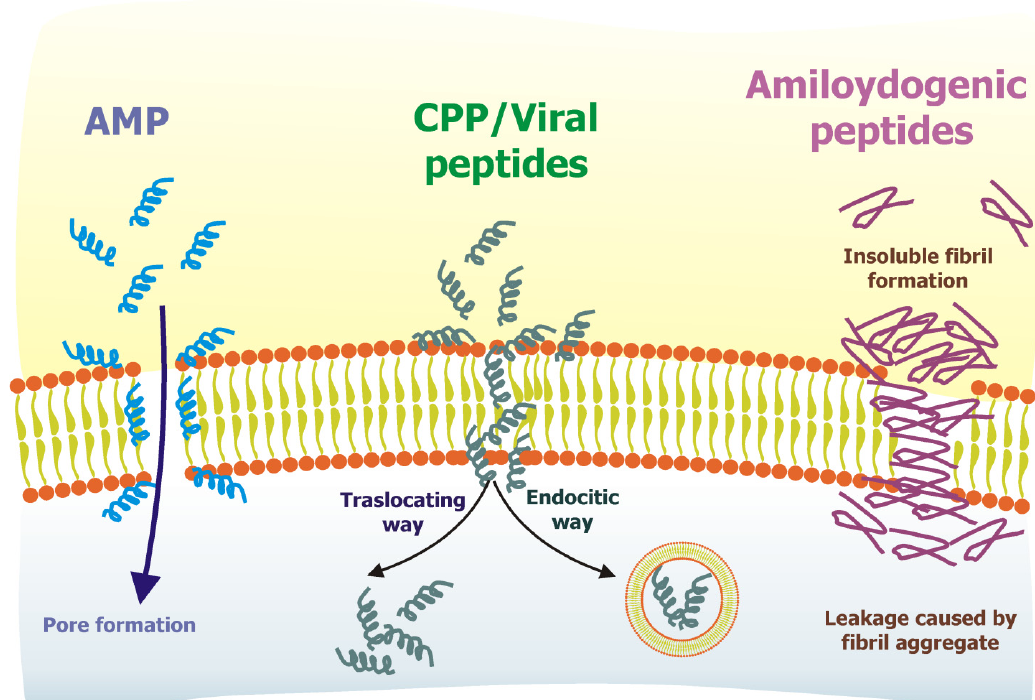
Figure 3. Mechanism of action of membrane-active peptides. Depending on their composition, charge and structure, different peptides employ different interaction mechanisms with the membrane. Examples of different membranotropic peptides: AMP (antimicrobial peptides); CPP (cell penetrating peptides), viral peptides and amiloydogenic peptides. Both CPP and viral derived peptides are able to penetrate into the cell through endocytosis or direct translocation. CPP have been mainly described to enter by endocytosis, while viral peptides seem to prefer a direct translocation